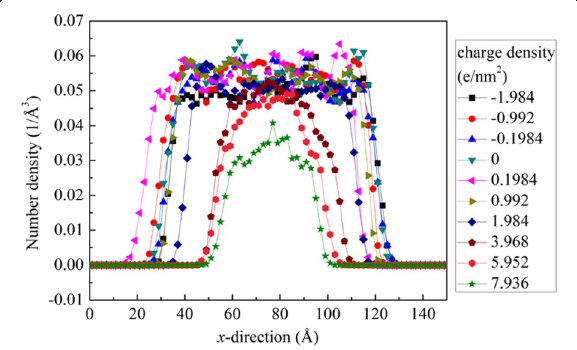
Fig. 5 Density distributions of oil molecules along the x -direction in the x - y plane with a height of 1.9 nm in the z -direction